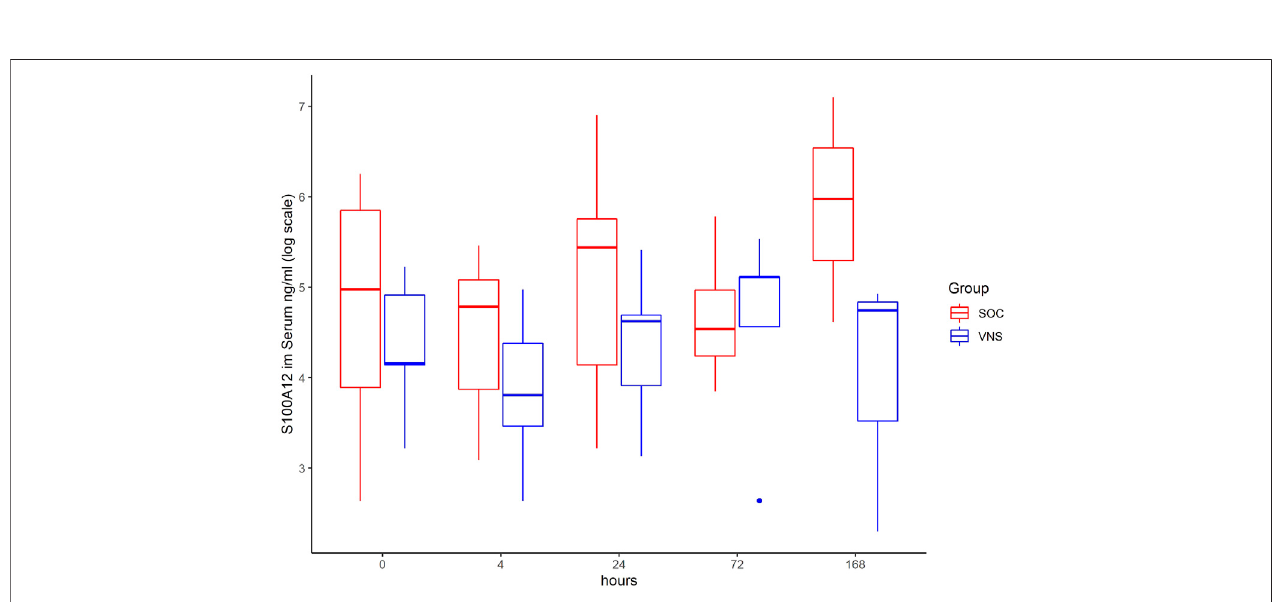
FIGURE 6 | Median S100A12 level with Interquartile Range of patients receiving auricular Vagus Stimulation (VNS = blue) and patients only receiving Standard of Care (SOC = red) after 0, 4, 24, 72, and 168 h of study inclusion.